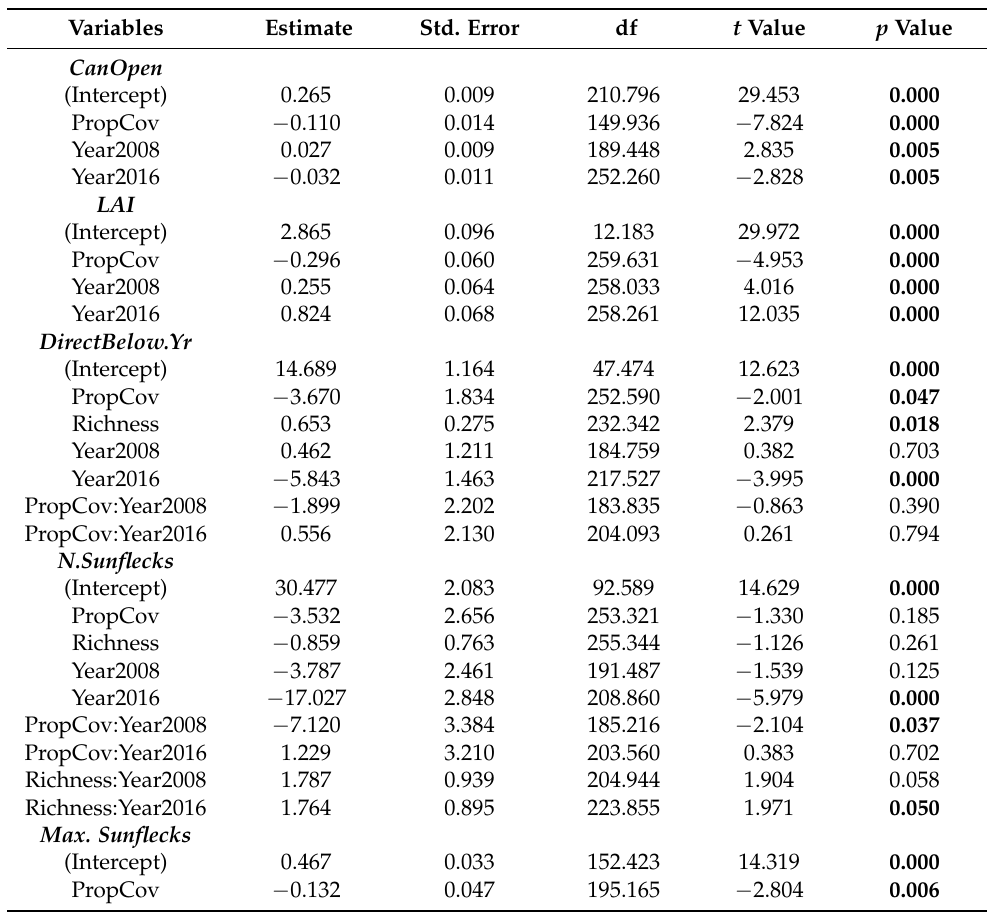
Table 3. Summary of the estimates for the “best model” accounting for the effect years, richness, and proportion of forest cover at explaining light variables, according to the AIC value, computed for an area of 5.0 m radius around each sampling point. Only the most significant values representing interactions between year, canopy richness, and proportion of forest cover are shown. Significant values ( p < 0.05) are in